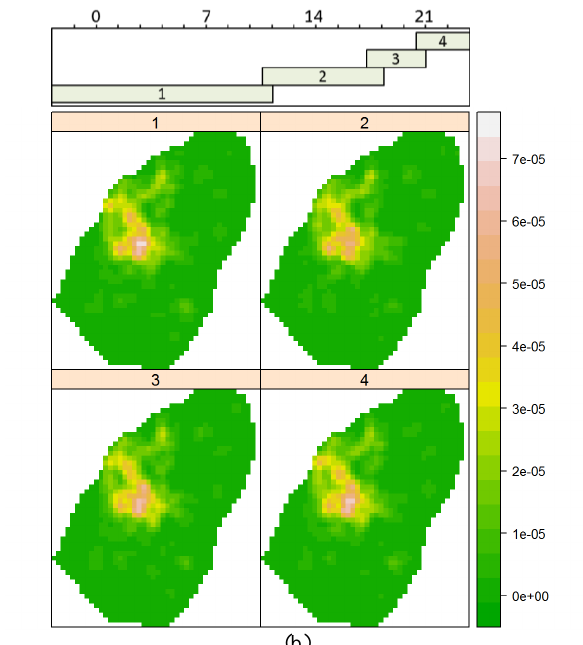
Figure 9. Univariate comaps by hour: (a) DW; (b) FL